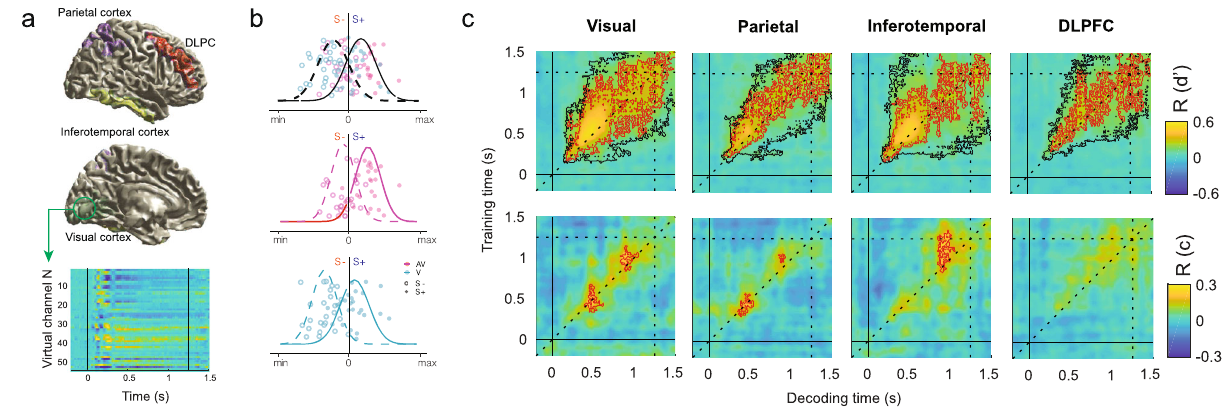
Fig. 3 Decoding sensitivity and criterion parameters from neural activity patterns. a Visual representation of the four anatomically de fi ned regions of interest overlayed on a hemisphere surface model of the MNI template. Source-reconstructed activity extracted from the virtual channels that conform each ROI (e.g., visual cortex) is used to test and train a multivariate classi fi er (bottom part). b A multivariate pattern classi fi er was trained on visual and audiovisual (green and magenta simulated points respectively) conditions together to optimally discriminate between S + and S − trials (empty and full circles respectively). The trained classi fi er was cross-validated on visual and audiovisual trials separately. The solid and dashed lines represent the probability density functions of the S + and S − trials distributions based on the discriminant channel output. Speci fi cally, trials with a discriminant channel output larger/smaller than 0 (vertical line) are classi fi ed as signal-present/absent respectively. We categorized S + trials classi fi ed as signal-present as hits, and the S − trials classi fi ed as signal-present as false alarms. Note that although a classi fi er might be equally good in discriminating S + from S − trials in all the conditions, there might be systematic biases to classify more often the trials in the audiovisual condition (middle panel) as signal-present than in the visual condition (bottom panel). c Correlation between behaviorally estimated and neurally decoded sensitivity (upper panels) and criterion (bottom panels) parameters. Red thin contours depict signi fi cant correlation clusters and black thin contours identify clusters in which the stimulus decoding sensitivity was larger than